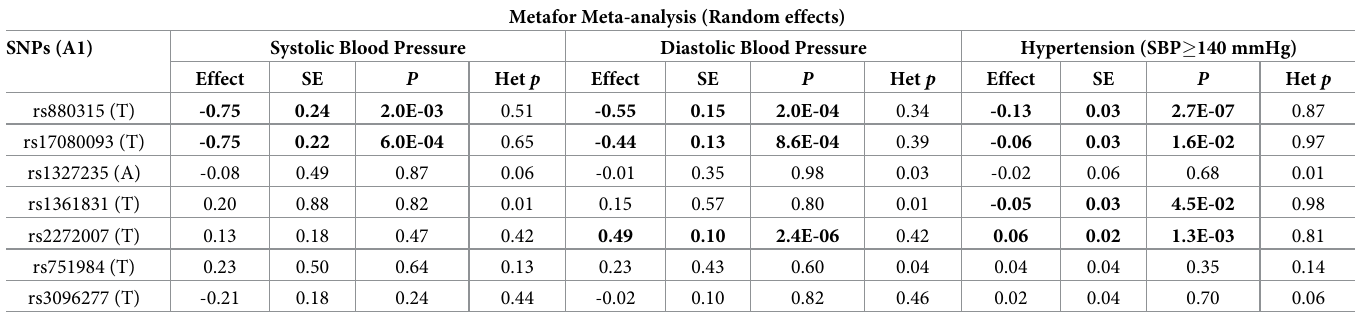
Table 5. Meta-analysis across BioVU and COGENT-BP